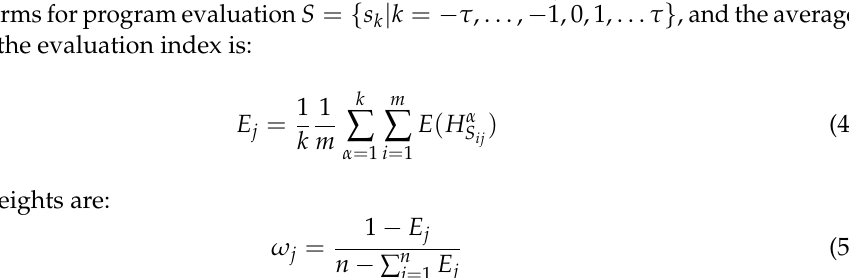
Table 2. Hesitant fuzzy linguistic term set decision matrix (cid:101) X 3 C 1 . . . C n A 1 { s − 1 } . . . { s − 3 , s − 2 } . . . . . . . . . A m { s − 1 , s 0 , s 1 } . . . { s 2 , s 3 } (cid:12) (cid:26) (cid:12) s (cid:12) δ α ij l